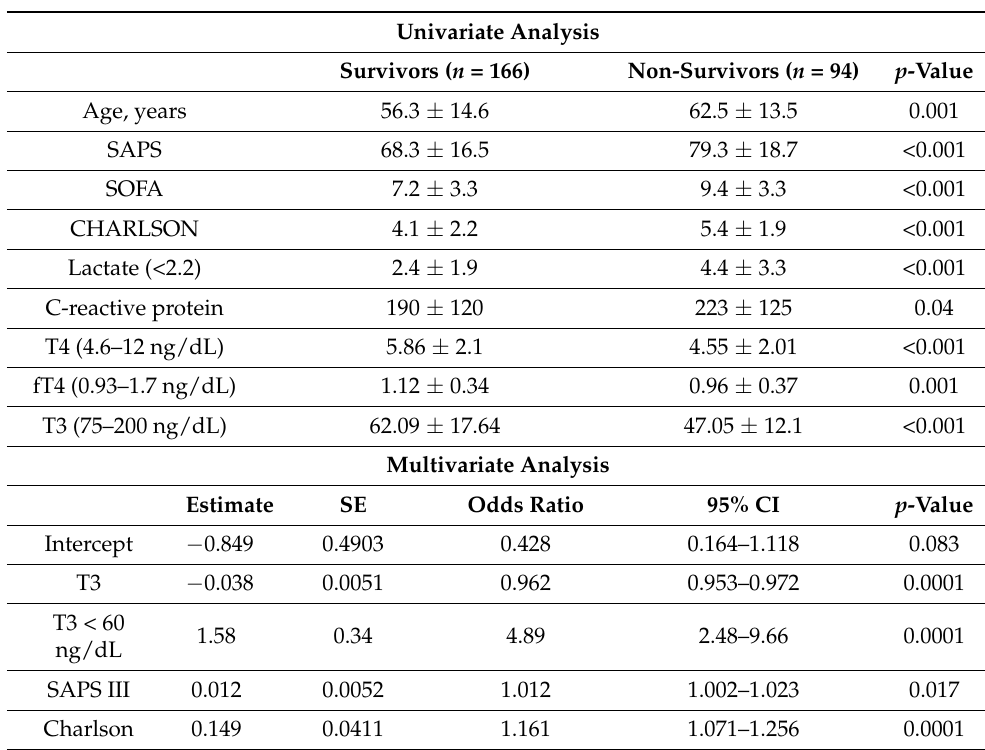
Table 2. Predictors of death within 28 days as identified by univariate analysis and multivariate logistic